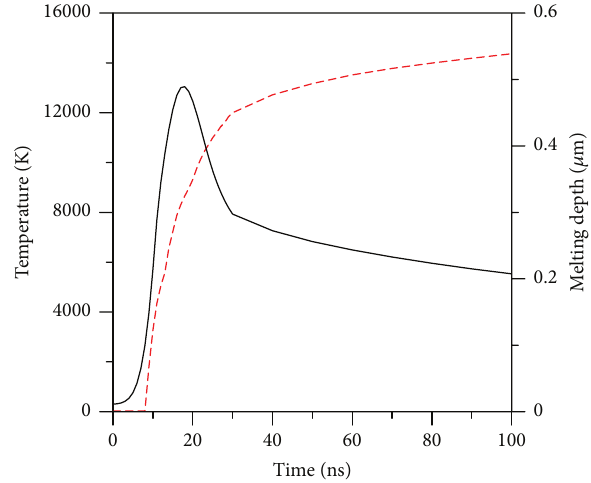
Figure 9: Target maximum temperature and melting depth during first 100 nanoseconds ( 𝑟 = 0 ). Broken line denotes melting depth of WB 2